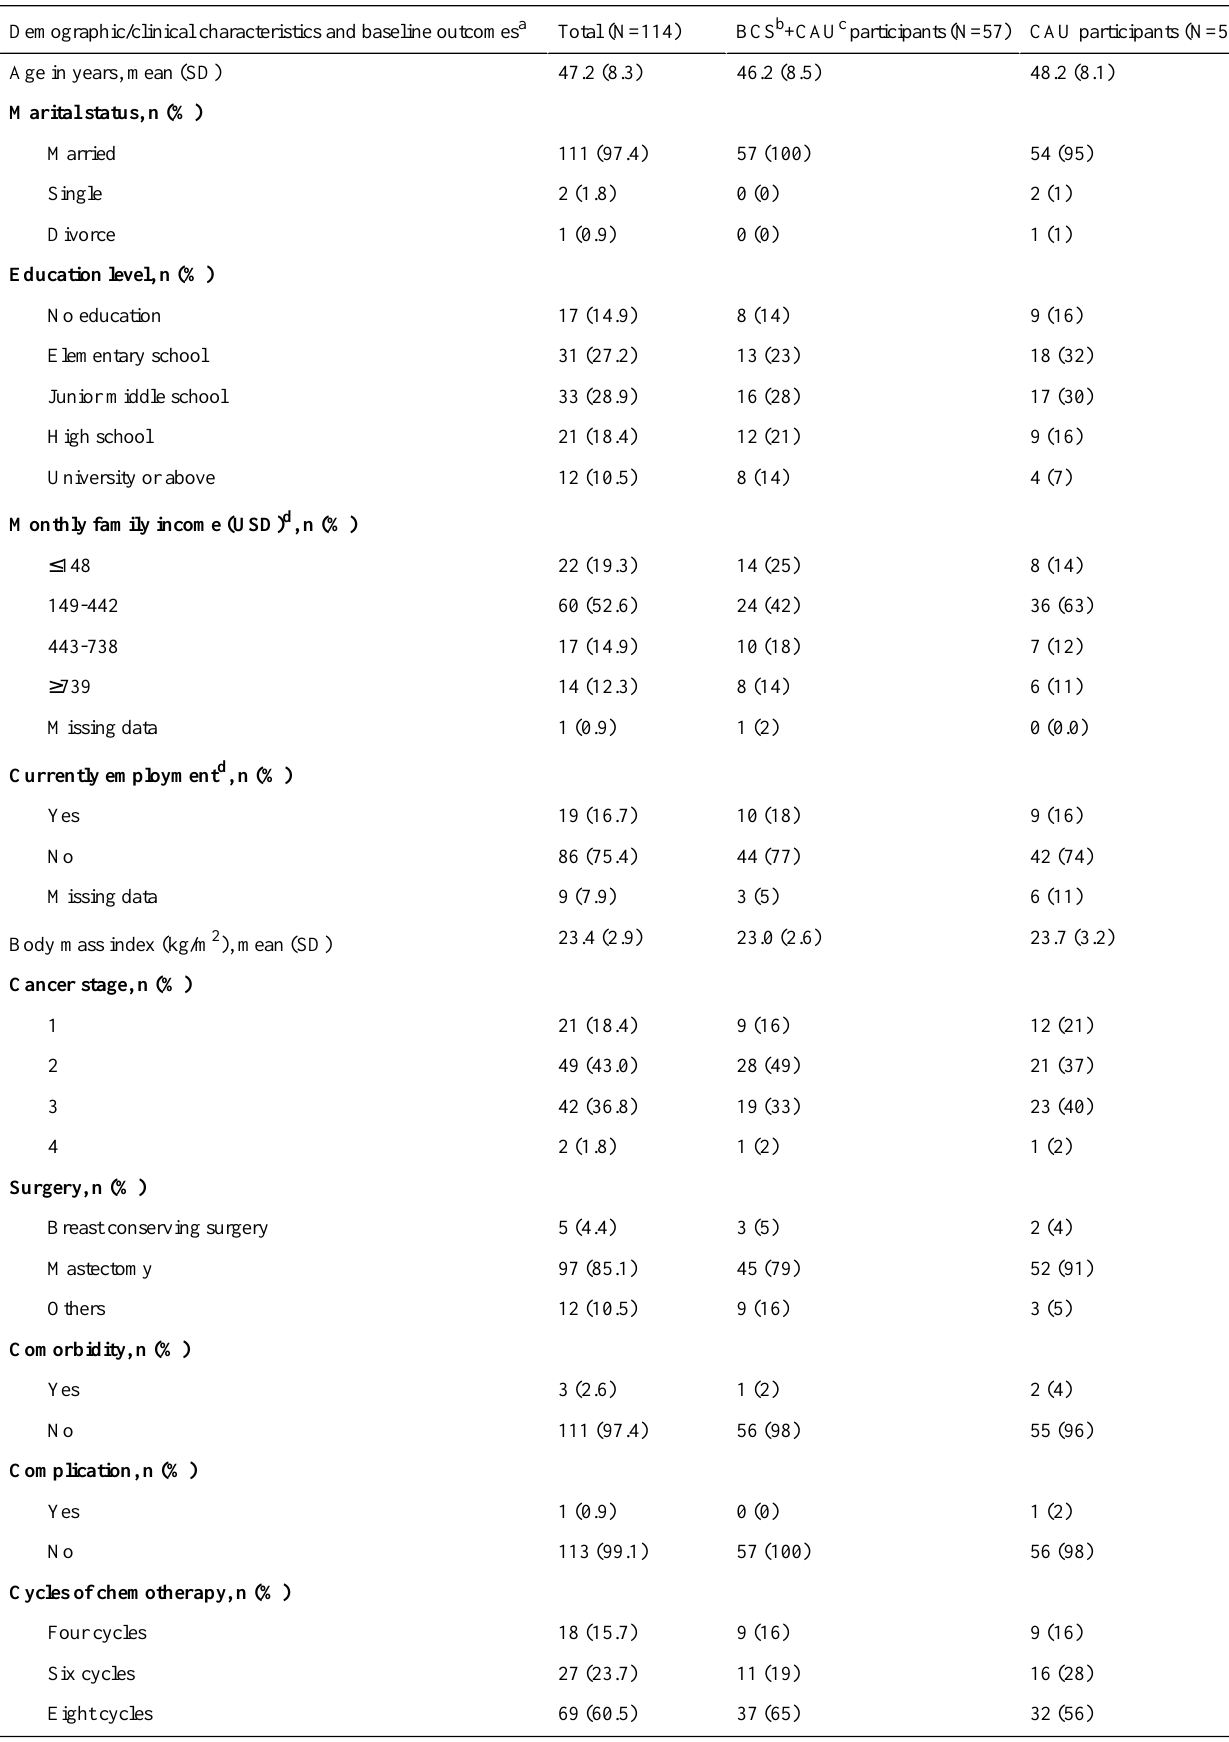
Table 1. Comparison of demographic/clinical characteristics and baseline outcomes between the groups